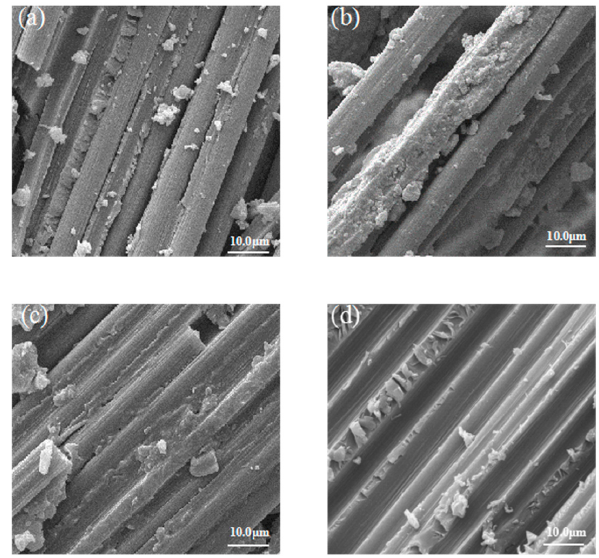
Figure 13. SEM images of the composites: ( a ) S1 sized CF with UPR ( b ) S2 sized CF with UPR ( c ) S3 sized CF with UPR ( d ) commercial epoxy sizing sized CF with UPR.